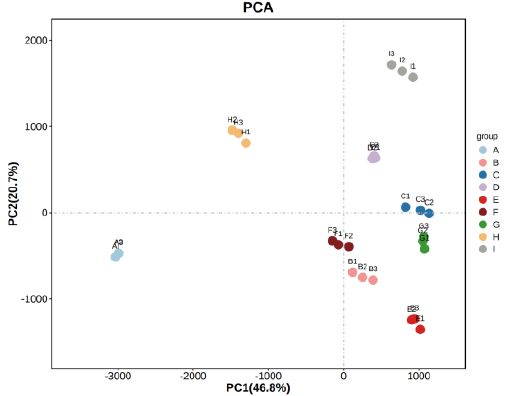
Figure 7. PCA analysis of the sample. Note: From A to I are ‘Hassan’, ‘Zuoshaner’, ‘Beibinghong’, ‘Zuoyouhong’, ‘Beta’, ‘Shuanghong’, ‘Zijingganlu’, ‘Cabernet Sauvignon’, and ‘Syrah’.